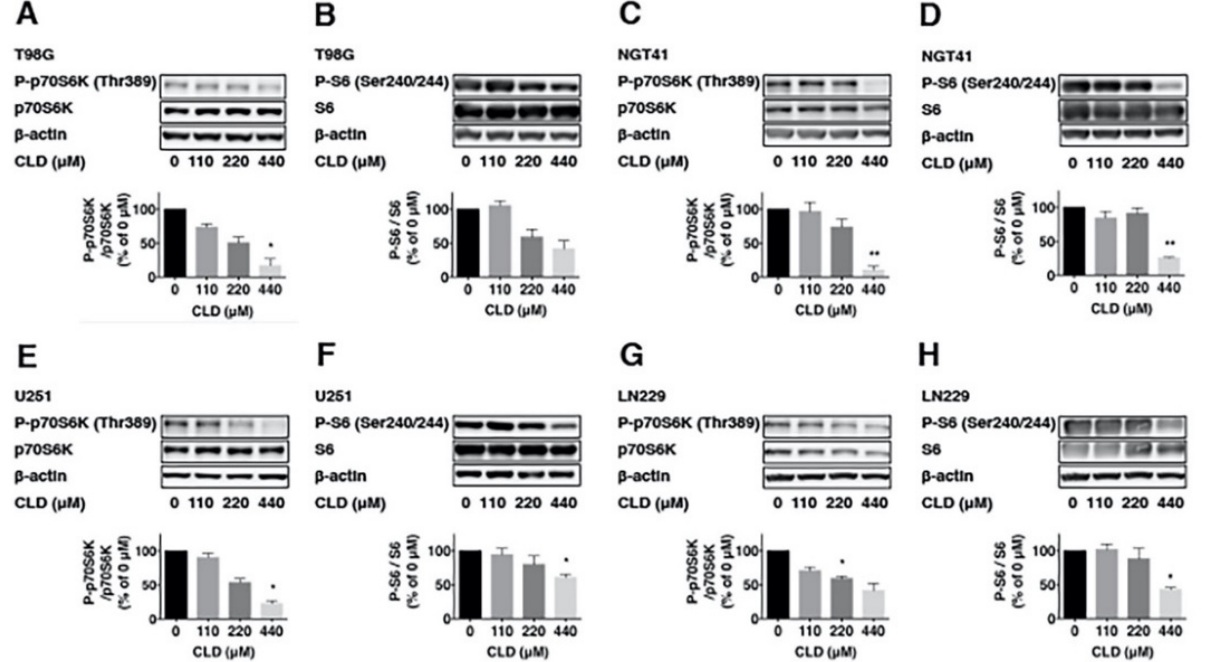
Figure 2. Effect of clindamycin on the phosphorylation of p70S6K and S6 in glioblastoma cell lines. Dose responses of clindamycin (CLD) on the phosphorylation of p70S6K at Thr389 and S6 at Ser240/Ser244 in glioblastoma cell lines. Cells were treated with CLD (0, 110, 220, or 440 μ M) for 72 h and subjected to Western blotting. The levels of phosphorylated and total p70S6K were indicated at the corresponding bands ( A , C , E , G ). Western blotting analysis was subjected to densitometric quantification after standardizing the ratio of phospho/total p70S6K (below panel). The phosphorylation and total S6 levels in glioblastoma cell lines were similarly analyzed via Western blotting ( B , D , F , H ). β -actin was used as the internal control level in all cases. Data are shown as the mean ± SE, similar results shown were representative of three independent experiments. Each group was compared to the 0 concentration level to determine statistical significance. (* p < 0.05 and ** p < 0.01 vs. control culture: one-way ANOVA).